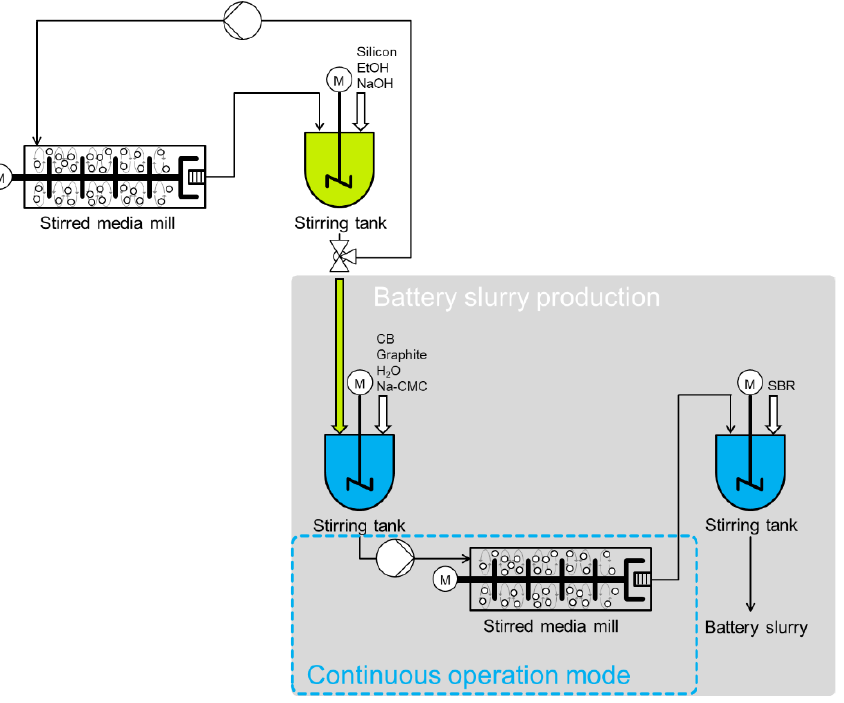
Figure 18. Plant diagram for the possible continuous operation of a stirred media mill (corresponding to the process variant: Conti-A) in the production of a battery slurry (area highlighted in grey).